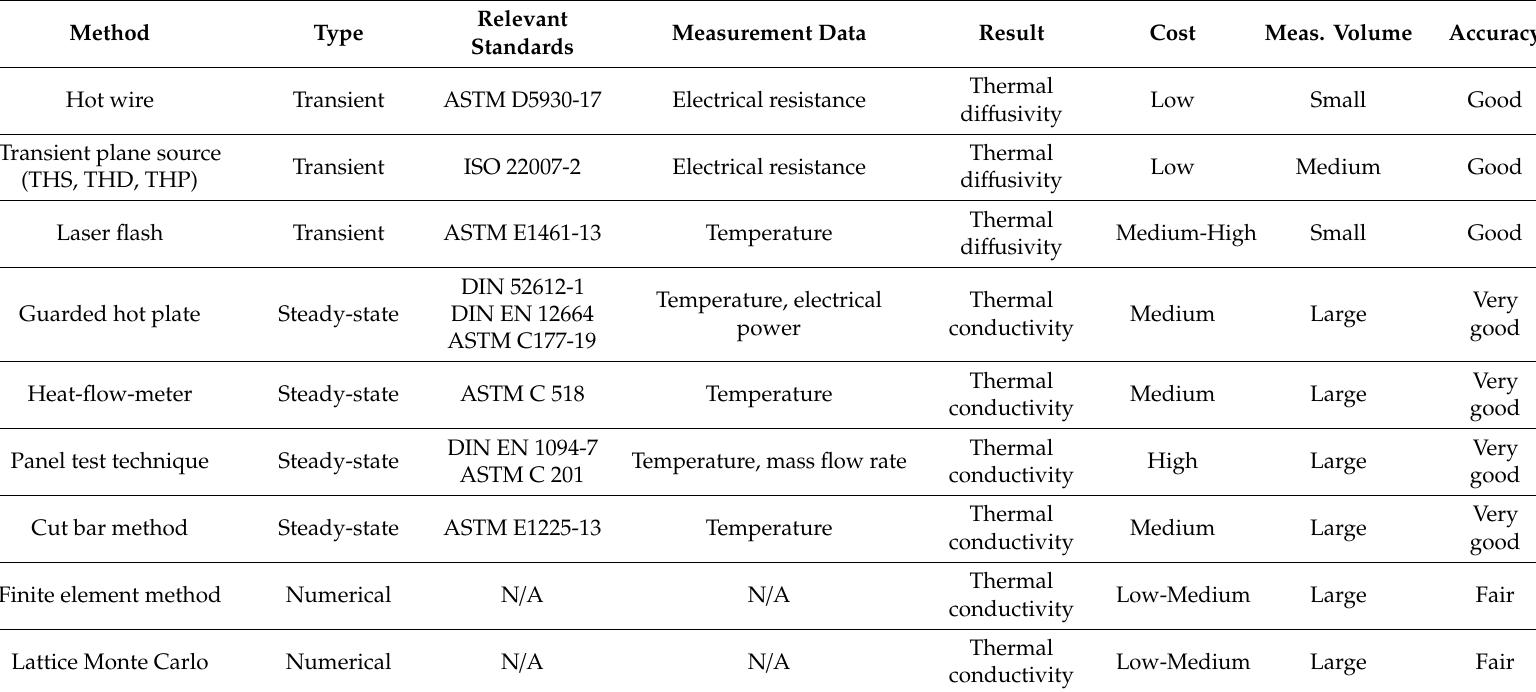
Table 1. Commonly used methods for the determination of the e ff ective thermal conductivity of cellular